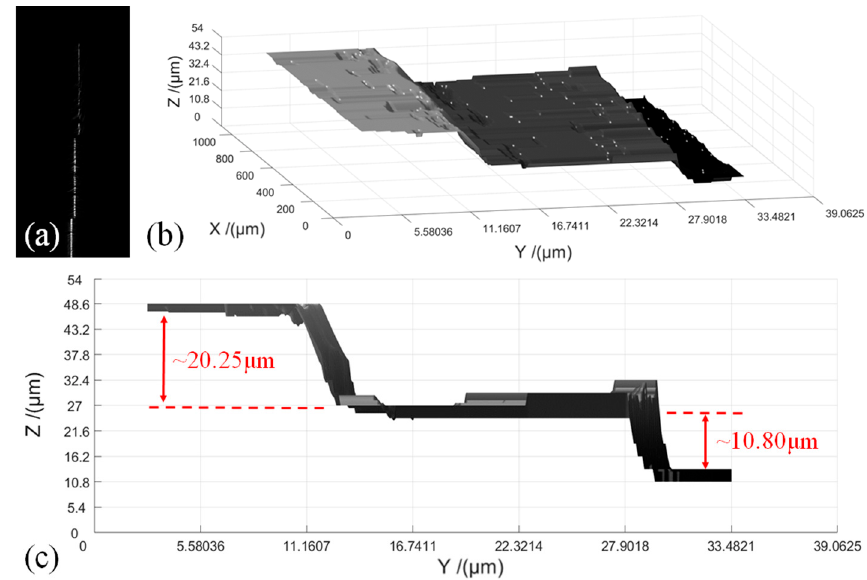
Figure 7. Measurement of height variations of two feeler gauges stacked in a stair shape. ( a ) Light- sheet modulated by two feeler gauges. ( b ) Calculated 3D topography of the feeler gauges. ( c ) Side view of the ′ stair ′ .